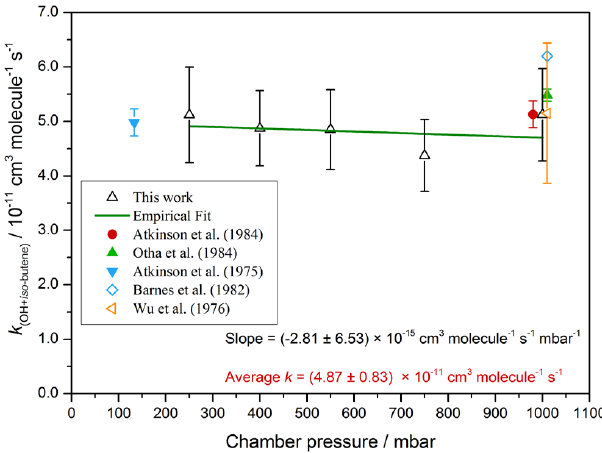
Figure 4. Rate constant, k OH , for iso -butene + OH over the 250– 1000mbar pressure range measured relative to an isoprene refer- ence in the HIRAC chamber. An empirical linear least-squares fit to the data is shown to emphasise lack of observed pressure de- pendence in the measured rate constant. Error bars represent the standard error ( ± 1 σ) in the associated relative rate determination of k OH , and linear regression is weighted to account for